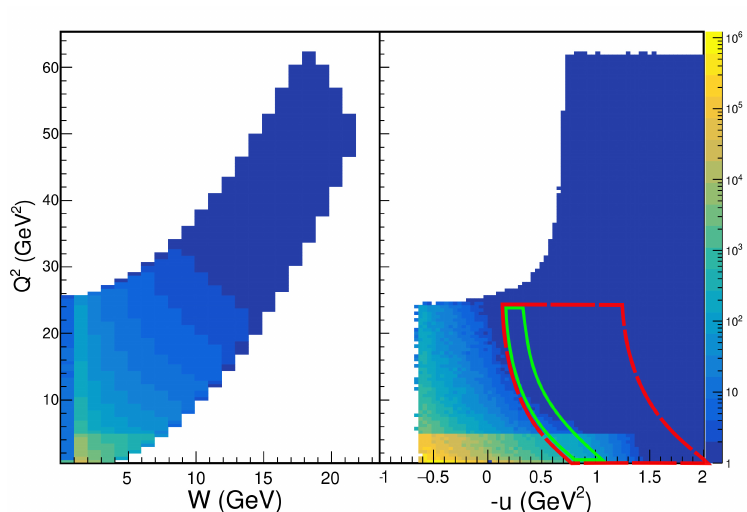
Figure 5: Left: Q 2 vs W coverage for e + p → e (cid:48) + p (cid:48) + π 0 , where at least one γ is detected by the ZDC. Right: Q 2 vs − u coverage for all available s values, 0 < s < 400 GeV 2 . The red enclosed region represents Q 2 vs − u coverage at 9 < s < 11 GeV 2 ; the green enclosed region is a subset of the red, and presents the coverage of events with both photons detected by the Zero-Degree